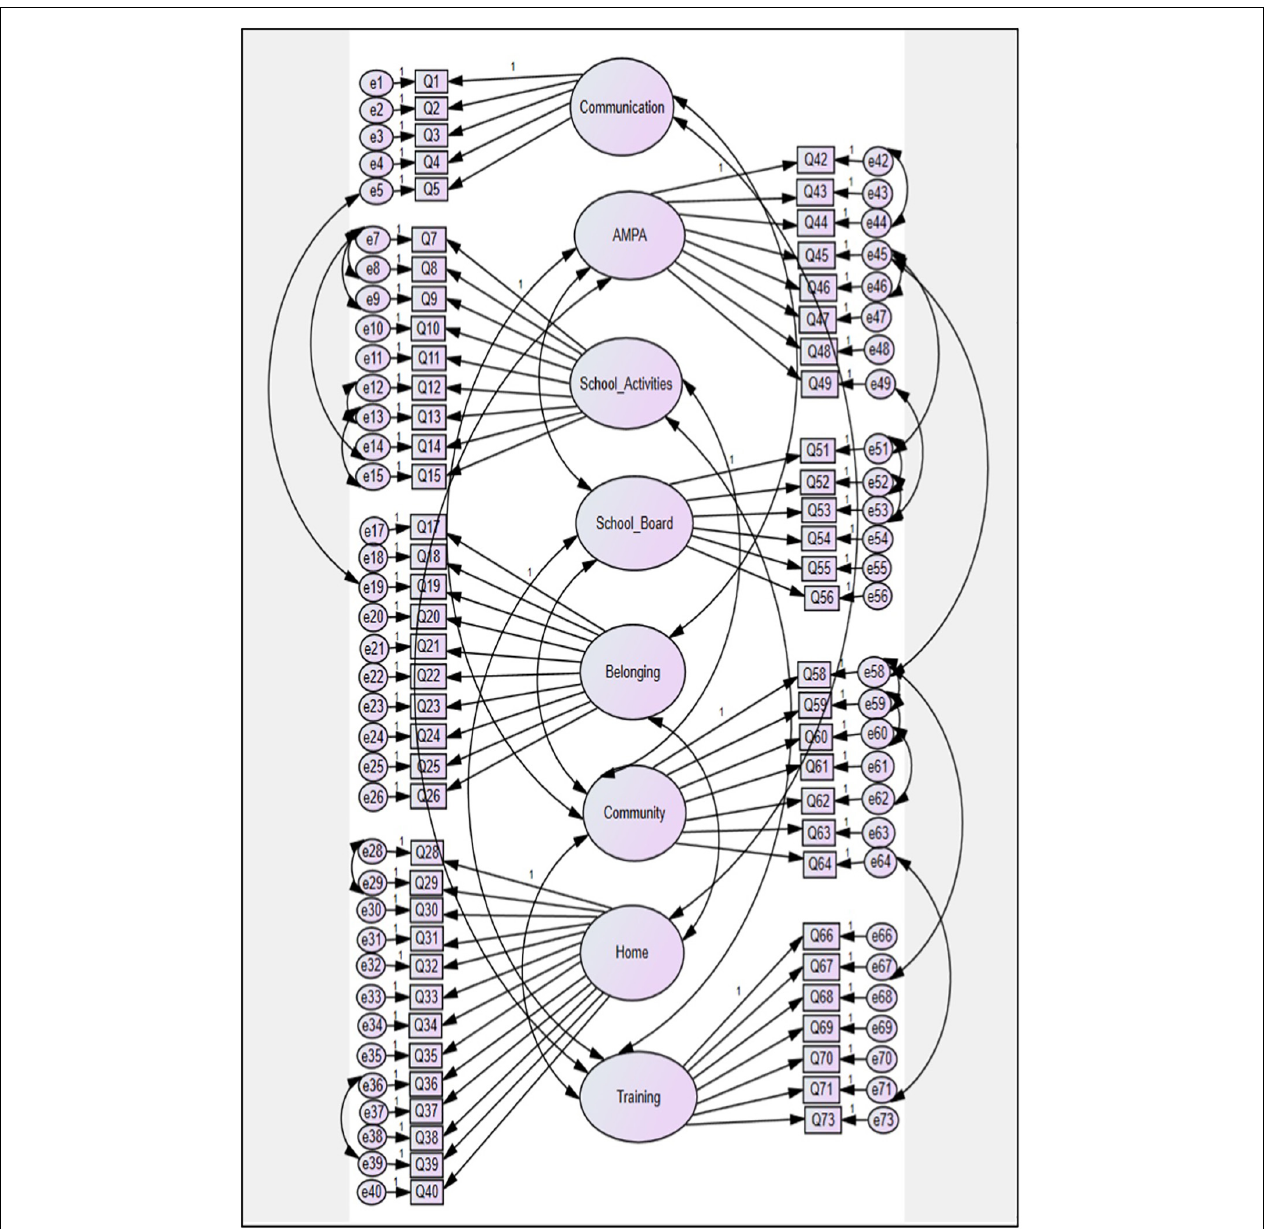
FIGURE 1 | Structural equations model of the